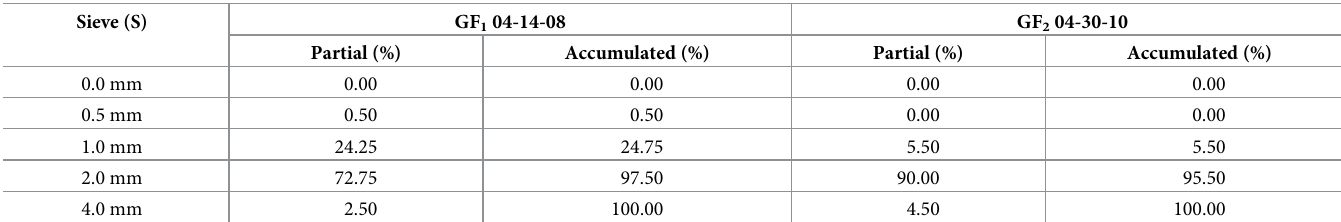
Table 4. Partial and accumulated amount of granular fertilizer passing through each sieve.